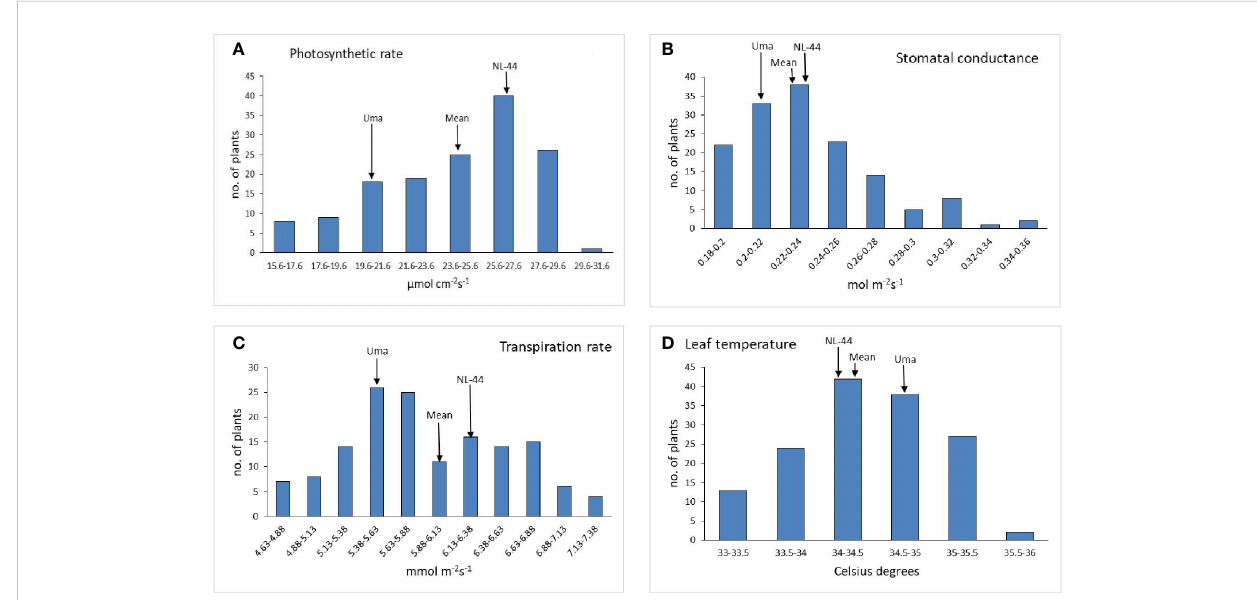
FIGURE 3 Frequency distribution of photosynthetic rate (A) , stomatal conductance (B) , transpiration rate (C) , and leaf temperature (D) under the effect of high temperature stress among the F 2